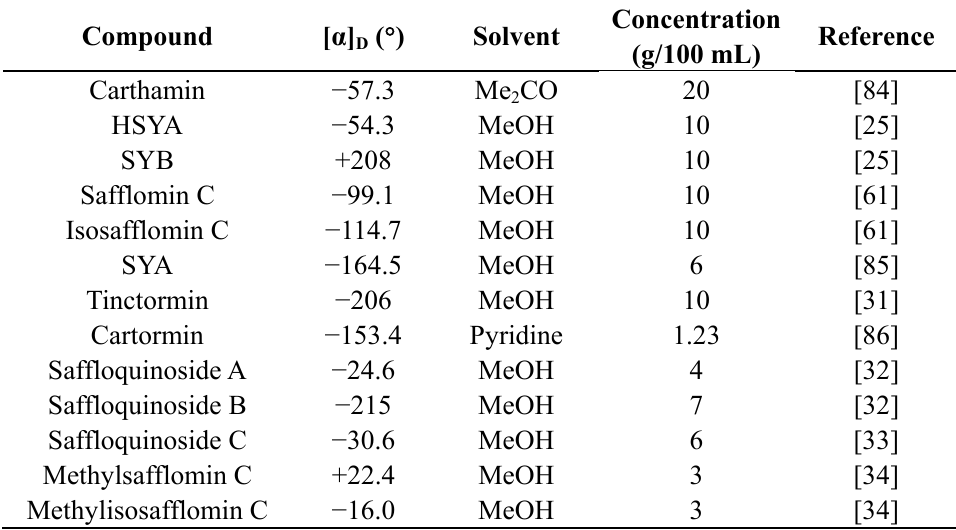
Table 6. Specific optical rotation of quinochalcone C -glycosides.